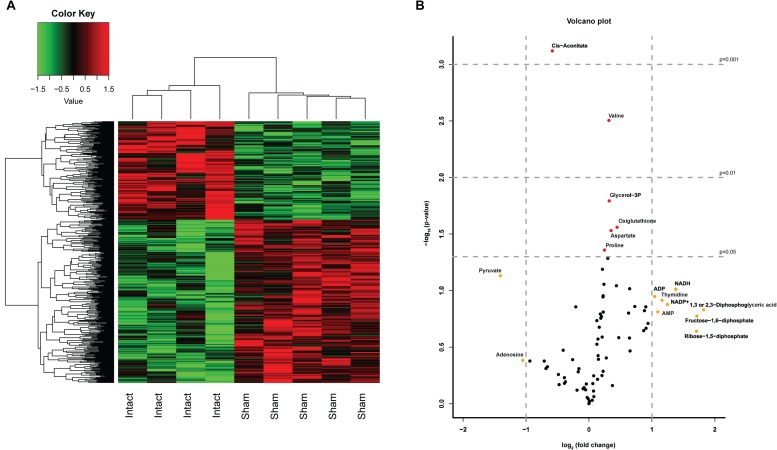
Effects of a Sham surgery on liver transcriptome and metabolome. (A) Heatmap of top 500 DEGs between Sham and Intact animals. A laparotomy caused a clearly distinct expression pattern even after 2 weeks of recovery. (B) Volcano Plot depicting the analysis of 78 metabolites in Sham-denervated and Intact-animals. The volcano plot shows a large number of metabolites with a divergent expression pattern due to the Sham surgery. Metabolites identified in red showed statistical significant changes of p < 0.05 (−log10 > 1.3) p < 0.01 (−log10 > 2) or p < 0.001 (−log10 > 3), metabolites in yellow showed a fold change > 2 (log2FC > 1).